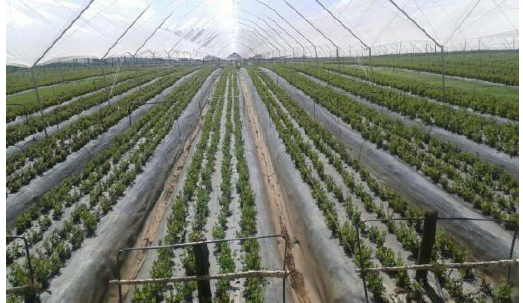
Figure A2. A picture of hypericum plants directly growing in the ground, on low beds that are covered by plastic under a greenhouse. At the foreground is support for drip line used for irrigation (the picture taken by Kimani M. David, on 9 February 2014 in